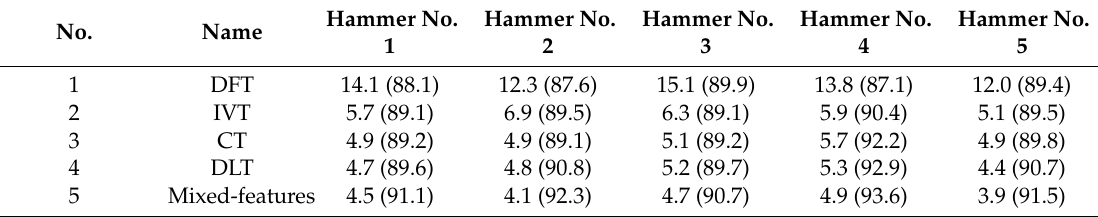
Table 5. Mean center errors (pixel) and the success rates (%) of different methods.